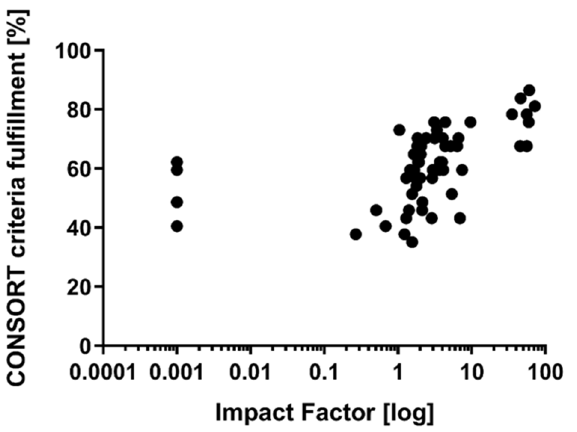
Figure 4. Correlation of impact factor of the publishing journal and CONSORT criteria fulfillment.